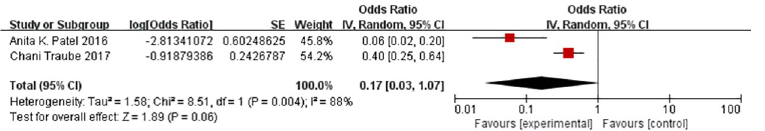
Fig 8. Forest plot for ages between 0 to 2 and > 13. We conducted meta-analysis for 2 studies using a random effects model. We used ORs and 95% CIs to represent the results.